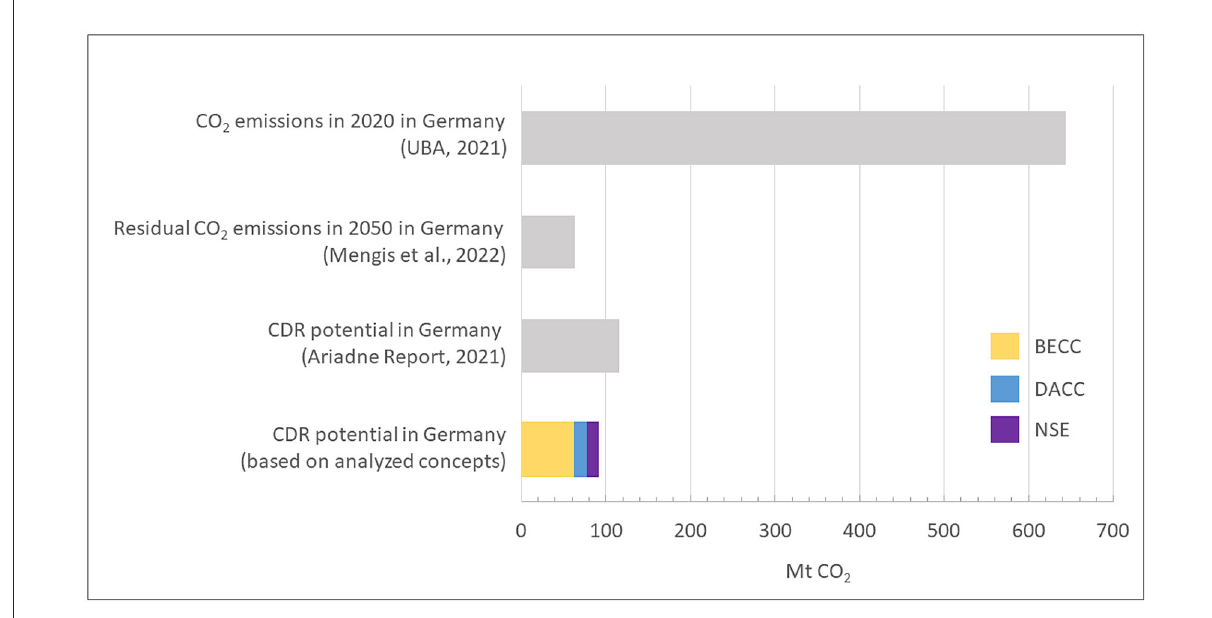
FIGURE3 CDR potential of analyzed concepts in comparison with estimates of current CO 2 emissions in Germany (UBA 2021), projected residual emissions for 2050 (Mengis et al., 2022) and CDR potential in Germany (Ariadne Report, 2021). BECC: based on all analyzed BECC concepts, likely requiring imports of woody biomass; DACC: based on decentralized DACC concept, excluding centralized DACC due to energy constraints; NSE: based on all analyzed NSE concepts. The indicated potentials for BECC and DACC do not include possible constraints due to legal restrictions for geological CO 2 storage in